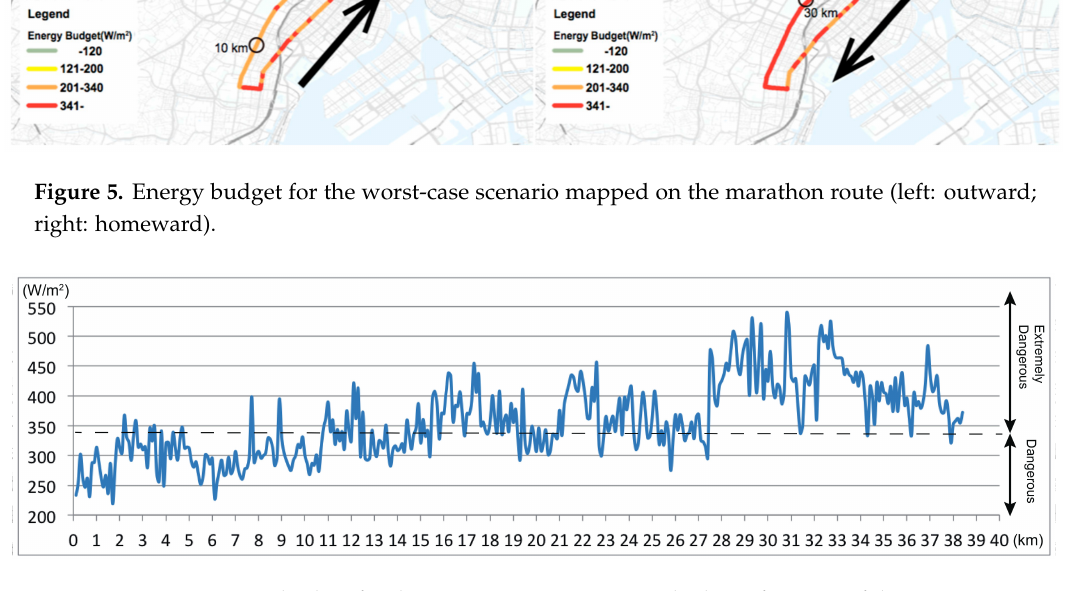
Figure 6. Energy budget for the worst-case scenario graphed as a function of distance.